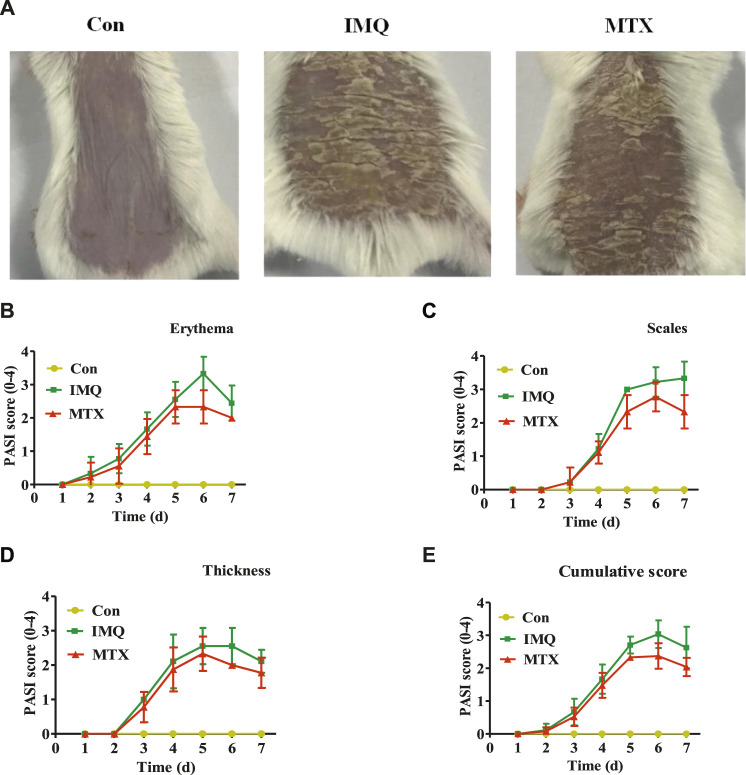
MTX treatment ameliorated IMQ-induced skin lesions. A mouse model of psoriasis was induced in mice by topical application of IMQ. Psoriasis-like skin lesions were monitored during 7 days in IMQ-treated animals. Administration of 1 mg/kg MTX exhibited ameliorated symptoms (data were represented as mean ± SD; n = 8). (A) Phenotypical presentation of the back skin in the different groups after IMQ exposure for 7 days. PASI score of erythema (B), scales (C), and thickness (D) on a scale from 0 to 4 and the cumulative score (E) were indicated.